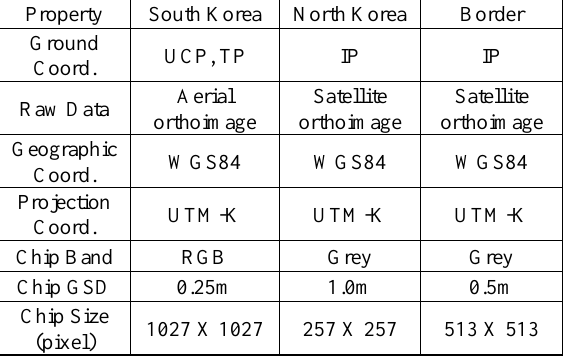
Table 1. Properties of used GCP Chip (UCP: Unified Control Point, TP: Triangulation Point, IP: Image Point). KOMPSAT-3A satellite images used for experiments have specifications as Table 2.